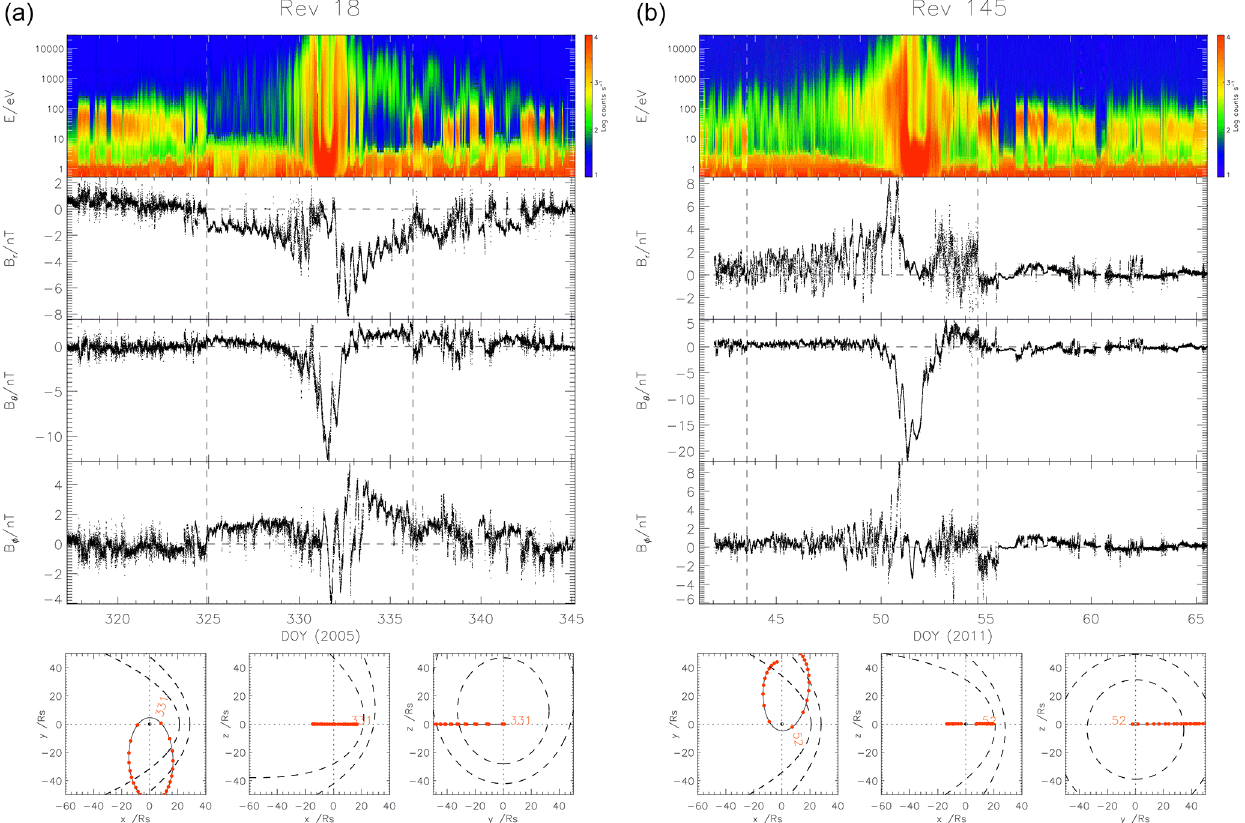
Figure 2. (a) Plot showing thermal electron, magnetic field, and trajectory data for Cassini Rev 18. From top to bottom the panels show (i) a CAPS-ELS electron count rate spectrogram covering the energy range ∼ 0.6–28 keV colour coded as shown on the right (the intense fluxes at few eV energies are principally spacecraft photoelectrons while the fluxes seen over the whole energy band closest to periapsis are due to penetrating radiation belt particles), (ii) the spherical polar radial r , co-latitudinal θ , and azimuthal ϕ components of the magnetic field referenced to the planet’s northern spin (and magnetic) axis, from which the three-term Burton et al. (2010) model of the internal planetary field has been subtracted (except for the ϕ component since the planetary field has no measurable azimuthal field), and (iii) the spacecraft trajectory in KSMAG coordinates mapped to the x – y , x – z , and y – z planes together with beginning of day markers (red circles) and the Kanani et al. (2010) and Masters et al. (2008) magnetopause and bow shock models for 0.03nPa as in Fig. 1. Time along the bottom of the upper panels is in DOY 2005. The vertical dashed lines show the last magnetopause crossing observed inbound, and the first crossing observed outbound. (b) Plot showing thermal electron, magnetic field, and trajectory data for Cassini Rev 145, in the same format as (a) . In this case time along the bottom of the upper panels is in DOY